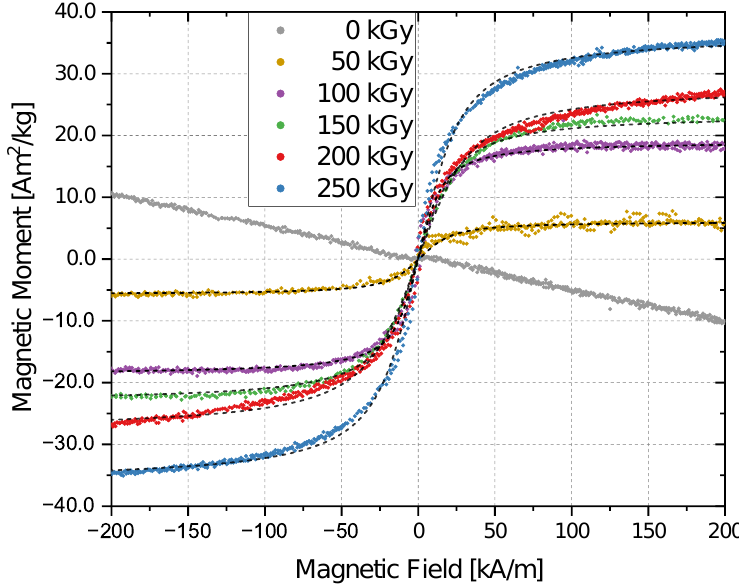
Figure 6. Magnetic moment depending on the applied magnetic field. The graphs from 50kGy to 250kGy are corrected for the diamagnetic part. The sample volume was 15µL. The black dashed lines show a Langevin fit (Equation (4)) to each of the associated